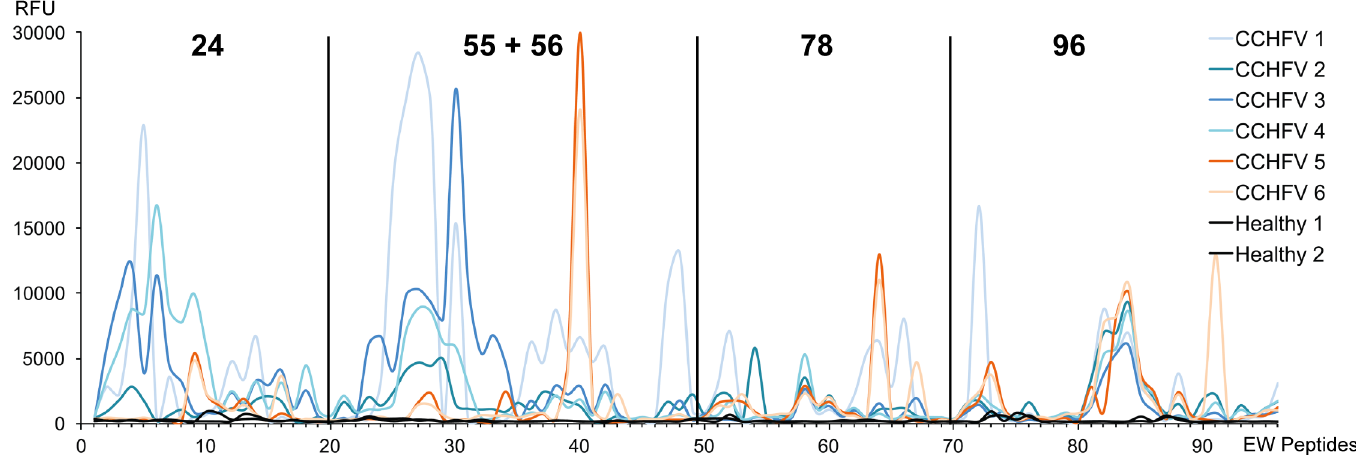
Fig 2. Epitope walk (EW) of selected five peptides (p24, p55, p56, p78 and p96). Figure illustrates the RFU of individual serum samples from CCHFV survivors from Turkey to selected peptides. Epitope walk sequences are found in S3 Table. In general two different patterns were seen when screening the epitopes (colored in blue and